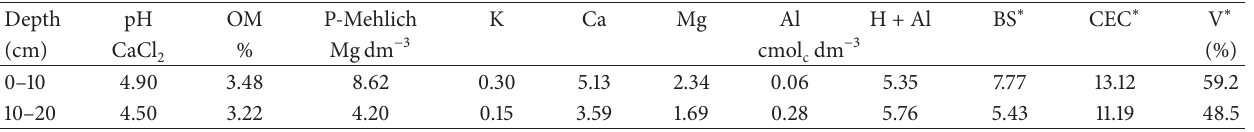
Figure 1: Soil water balance and mean temperatures of the experimental area during the period from November 2010 to April 2012. Table 1: Chemical soil characteristics prior to sowing of sorghum in